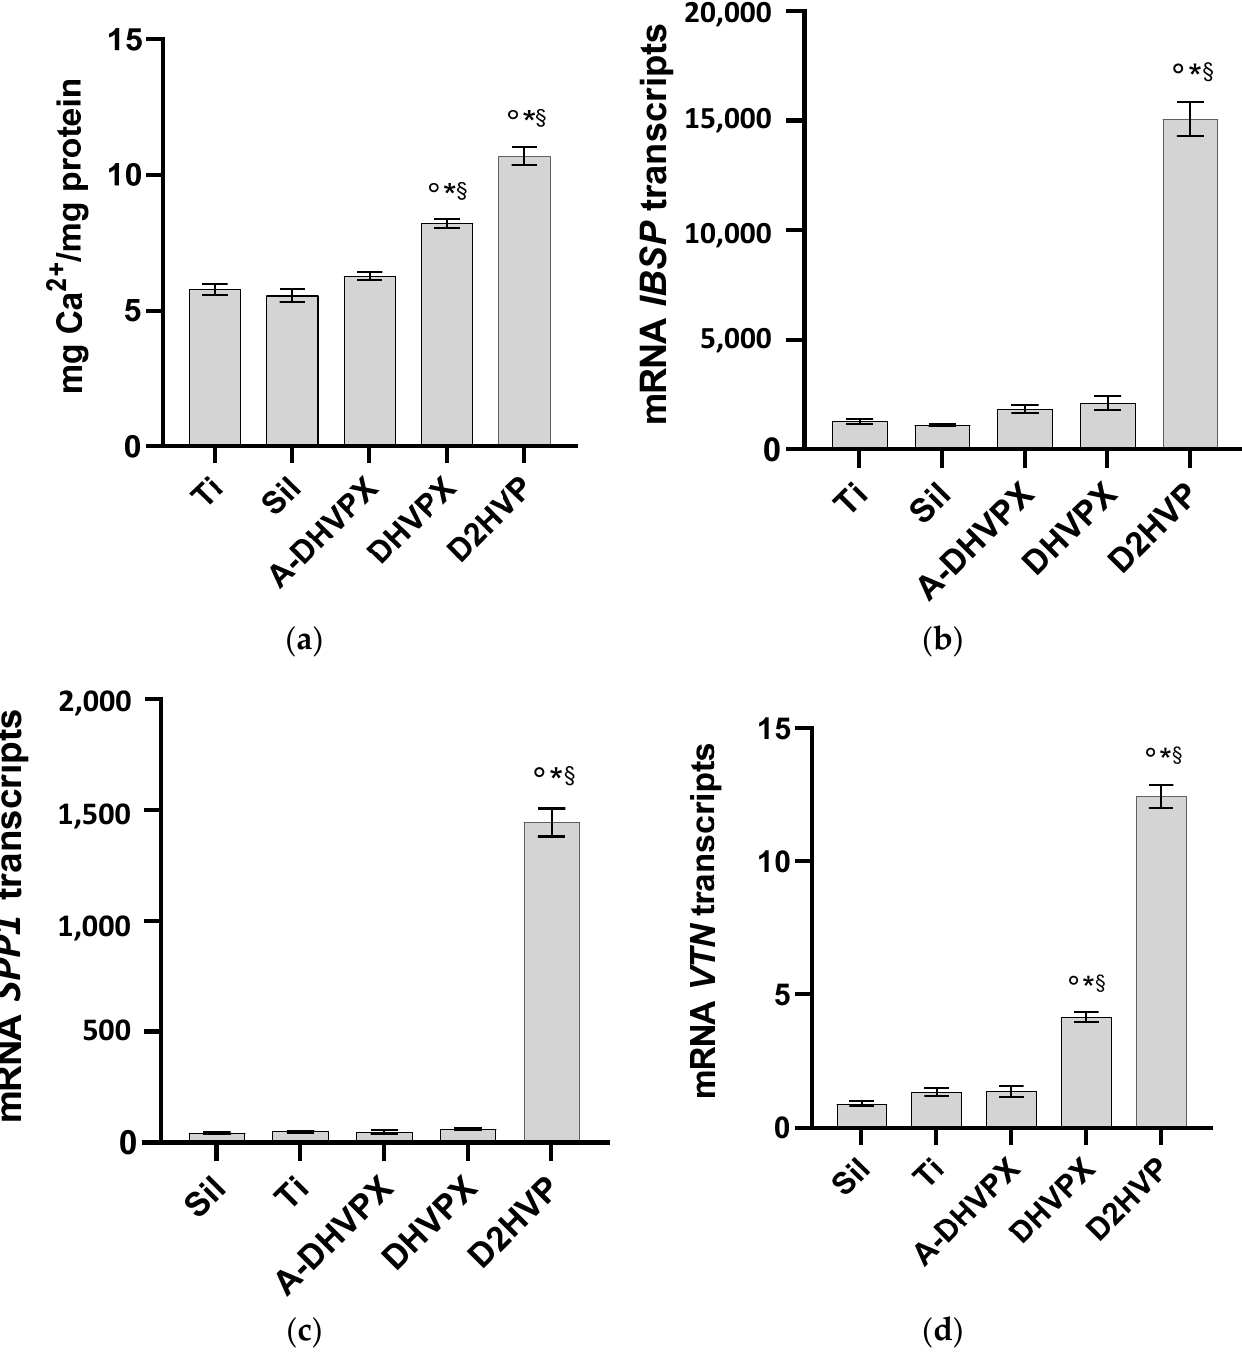
Figure 4. Mineralization and osteogenic differentiation. Osteoblast calcium deposition was evaluated following 7 days of culture ( a ). Gene expression for integrin-binding sialoprotein (IBSP) ( b ), secreted phosphoprotein 1 (SPP1) ( c ), and vitronectin (VTN) ( d ) was evaluated on cells cultured on differently functionalized Ti disks. “Ti” represents sandblasted and oxidized titanium disks. “Sil” represents the silanized titanium disks. * Denotes p < 0.05 vs. Sil; § p < 0.05 vs. Ti; ° p < 0.05 vs. A- DHVP.